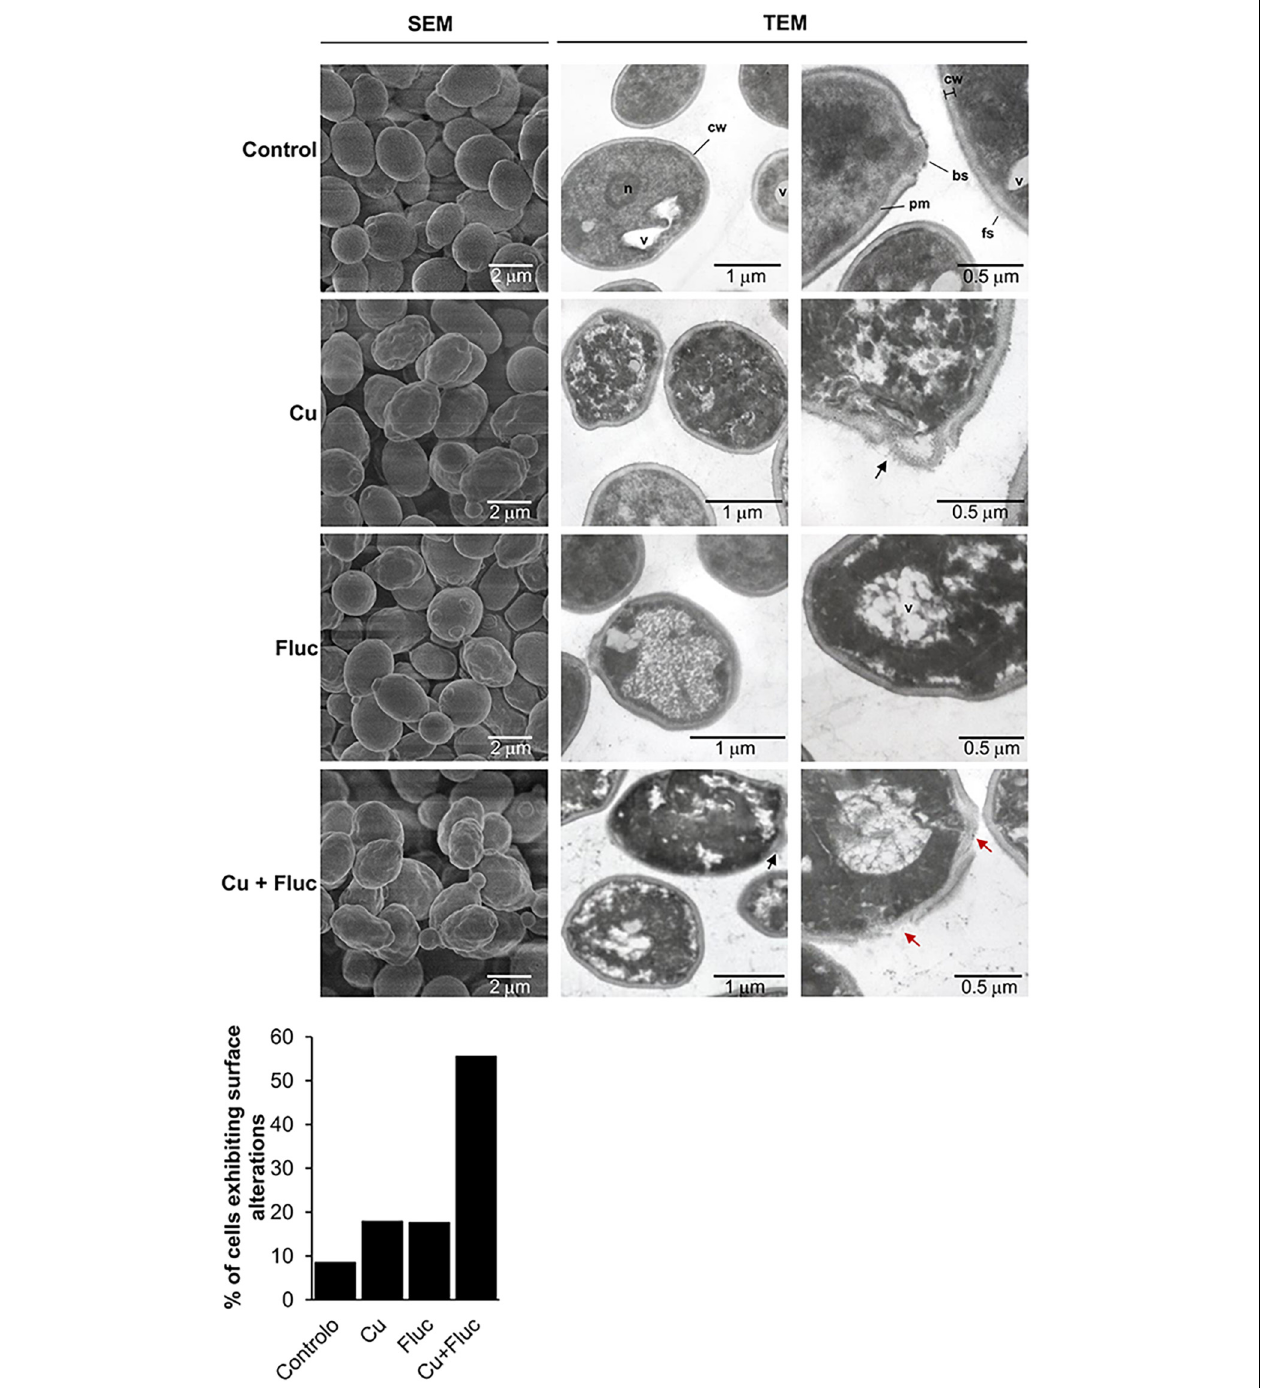
FIGURE 7 | Scanning electron microscopy (SEM) and transmission electron microscopy (TEM) images of Candida glabrata cells left untreated (Control), or treated with 625 µ M CuSO 4 (Cu), 32 µ g/mL fluconazole (Fluc), or both (Cu + Fluc) for 24 h. Control cells have regular cell walls (cw), from which fibrillar structures (f) protrude, well defined and continuous plasma membrane (pm) and visible vacuoles (v), nucleus (n), and bud scars (bs). Cells treated with Cu, Fluc or Cu + Fluc exhibit irregular surfaces and disorganized cytoplasm. Cu and Cu + Fluc stresses also induce defects in the cell wall (black arrows) and in the latter condition, loss of cell wall integrity (red arrows) was observable in some cells. The graph indicates the percentage of cells exhibiting surface abnormalities. A total of 120 cells per condition were imaged by SEM and those with irregular surfaces were counted.